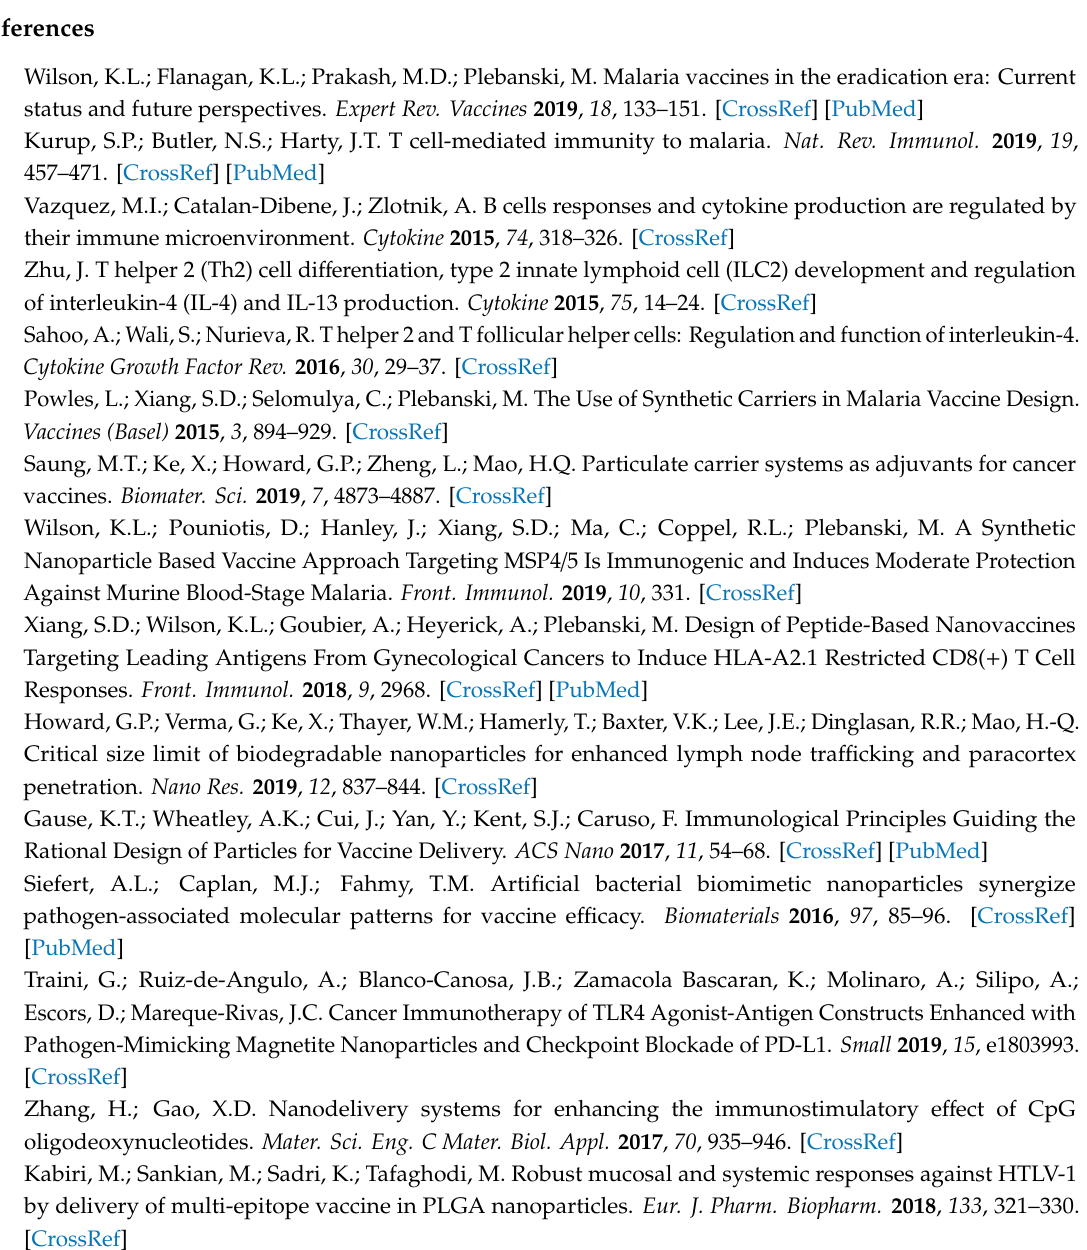
Figure S1: Fabrication and characterization of PEG- b -PLGA NPs; Figure S2: Nanovaccine antibody responses over 120 days; and Table S1: Statistical analysis of end titers over 120